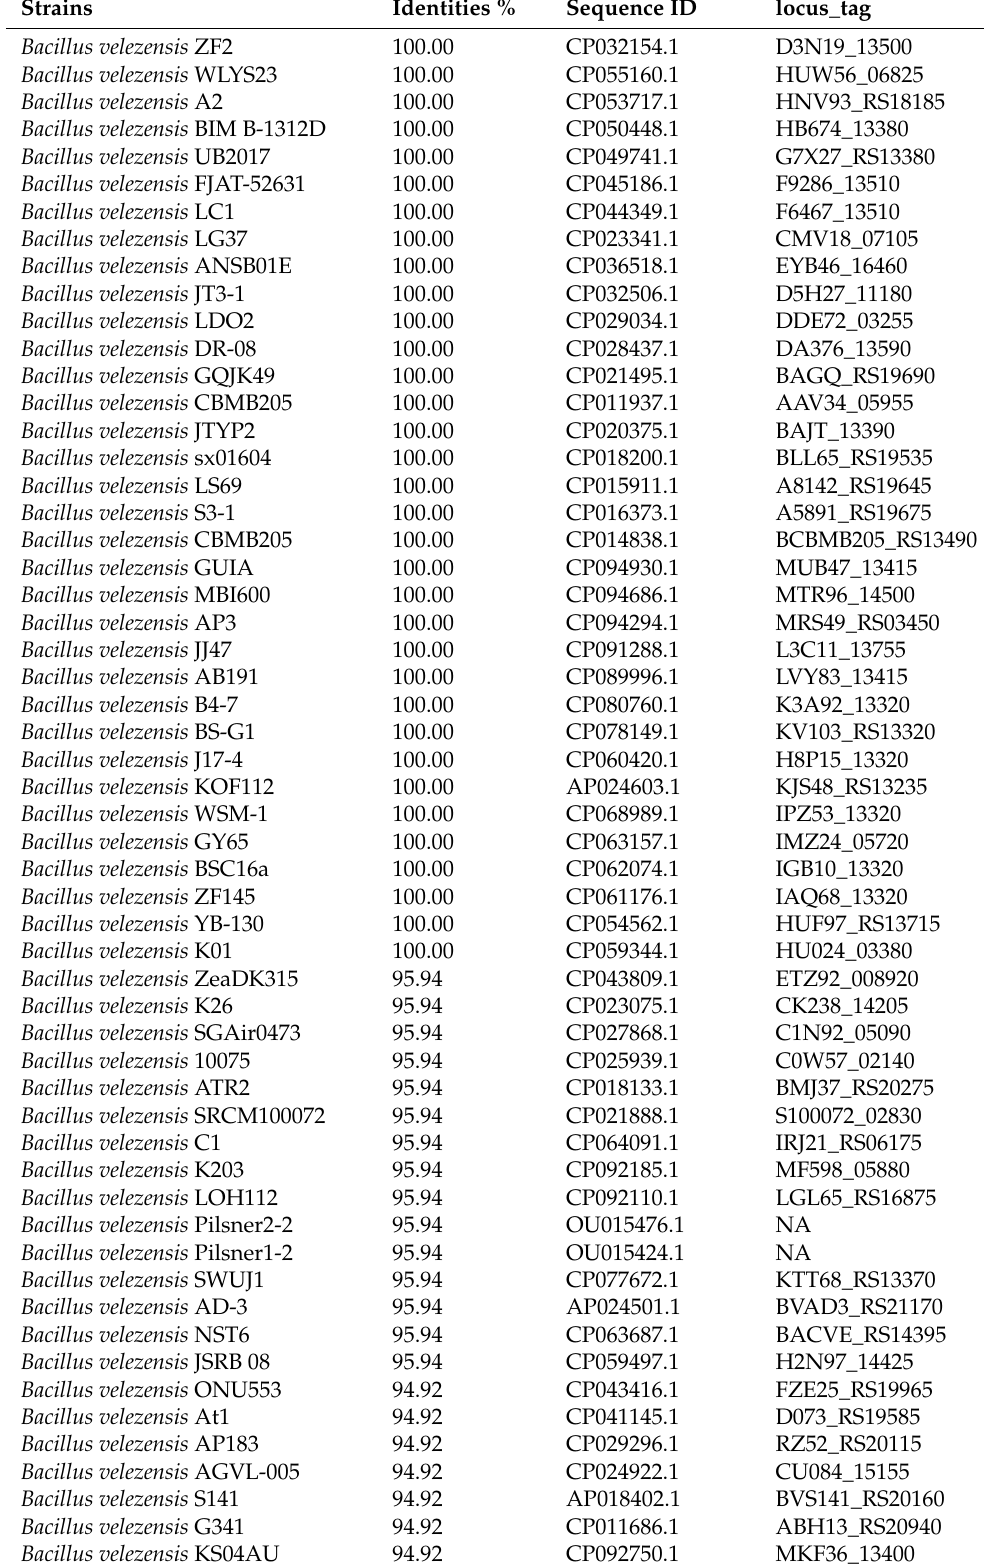
Table 2. Search results for D3N19_RS13500 gene in NCBI